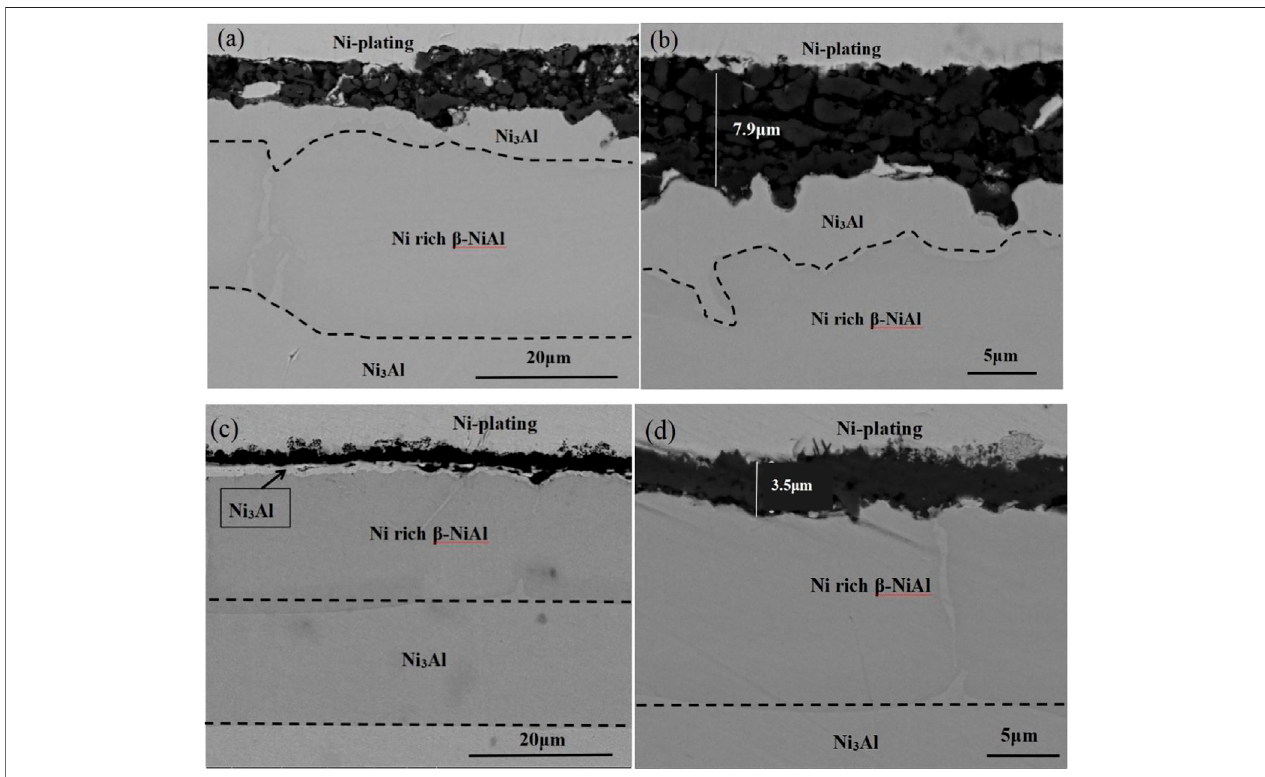
FIGURE 7 | Cross-sectional morphologies of the Al 2 O 3 scales on the (A) and (B) naked Ni 2 Al 3 coating, and (C) and (D) the Al 2 O 3 fi lm – covered Ni 2 Al 3 after 50 h of oxidation in the air at 1,000 ° C.